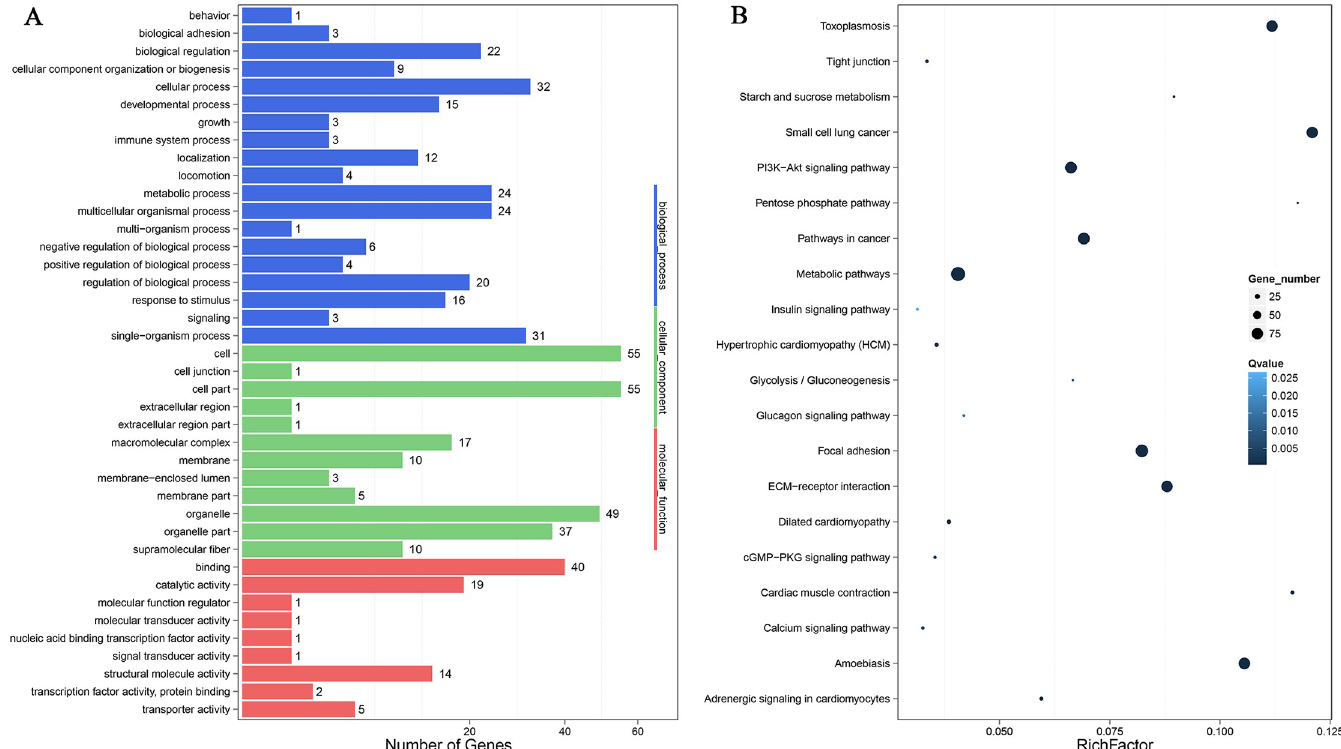
Fig 4. KEGG and GO analyses of DEGs. (A) GO functional annotation histogram of the DEGs. The vertical axis represents the three GO categories, the horizontal axis represents the gene number, and the number of genes is considered the difference in the proportion of the total. The GO annotations are classified in three basic categories, including cellular component, biological processes, and molecular function. (B) The degree of enrichment of the first 20 entries in the pathway. The pathway names are represented on the vertical axis, and the horizontal axis represents the pathways corresponding to the rich factor. The ratio of the number of DEGs and all annotated genes in the pathway is defined as the rich factor.